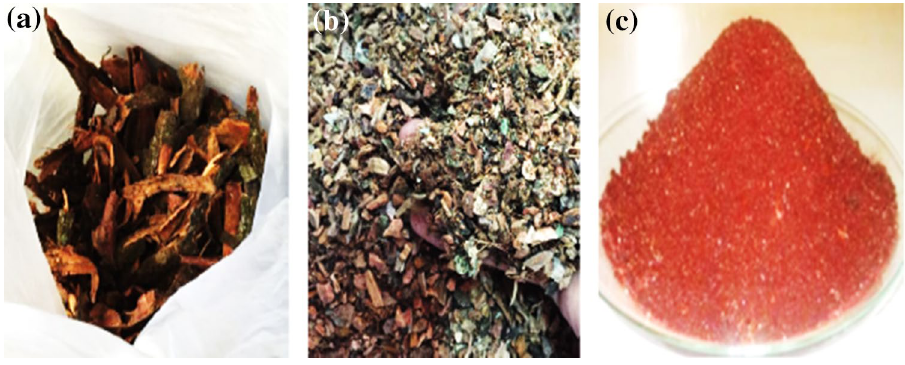
Fig. 4 a RMB from Kuala Sepetang, b ground RMB and c processed RMB in powdered